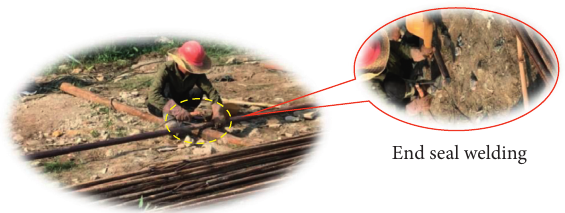
Figure 3: Electric welding process of steel tube.